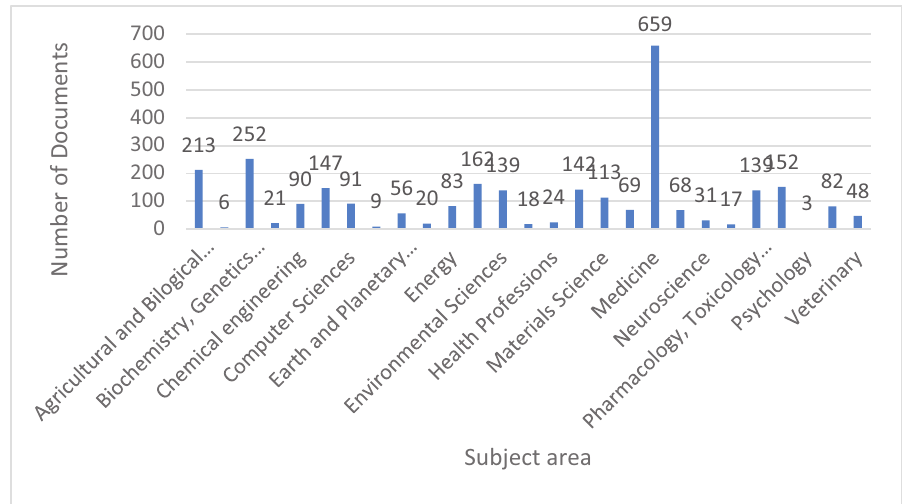
Figure 3 : Number of Sudanese documents published in 1996–2021 according to the different subject areas (based on Scopus data as of April